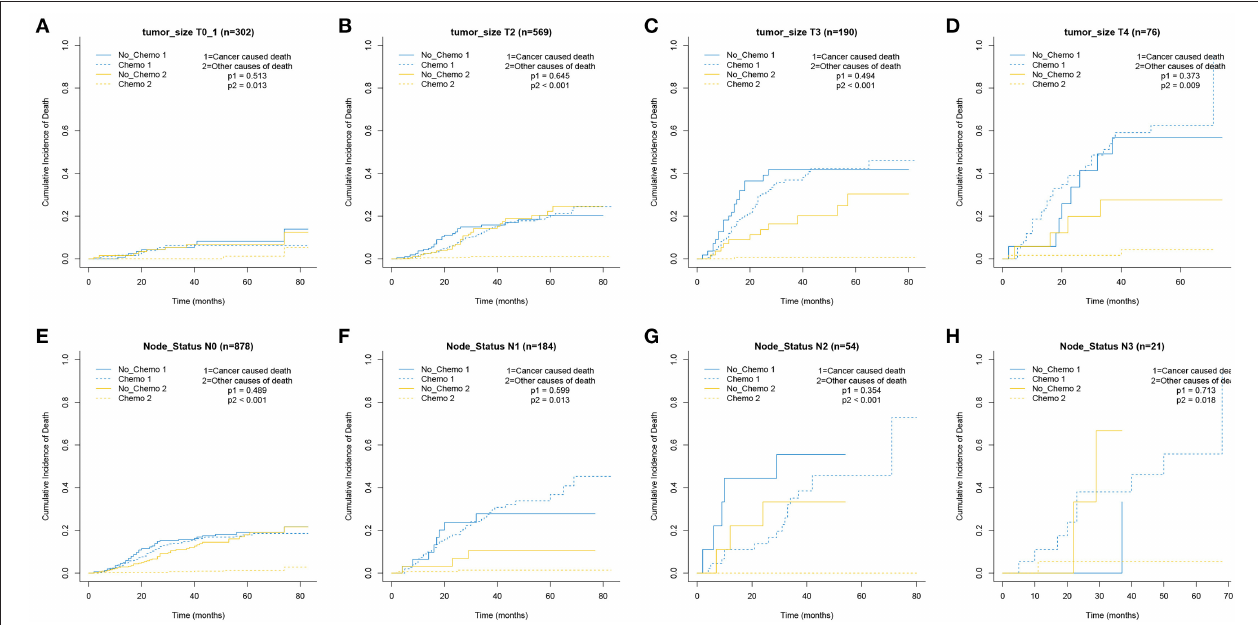
FIGURE 3 | Cumulative incidence plot depicting cancer-caused death and other cause mortality according to tumor size (A–D) and node status (E–H) .